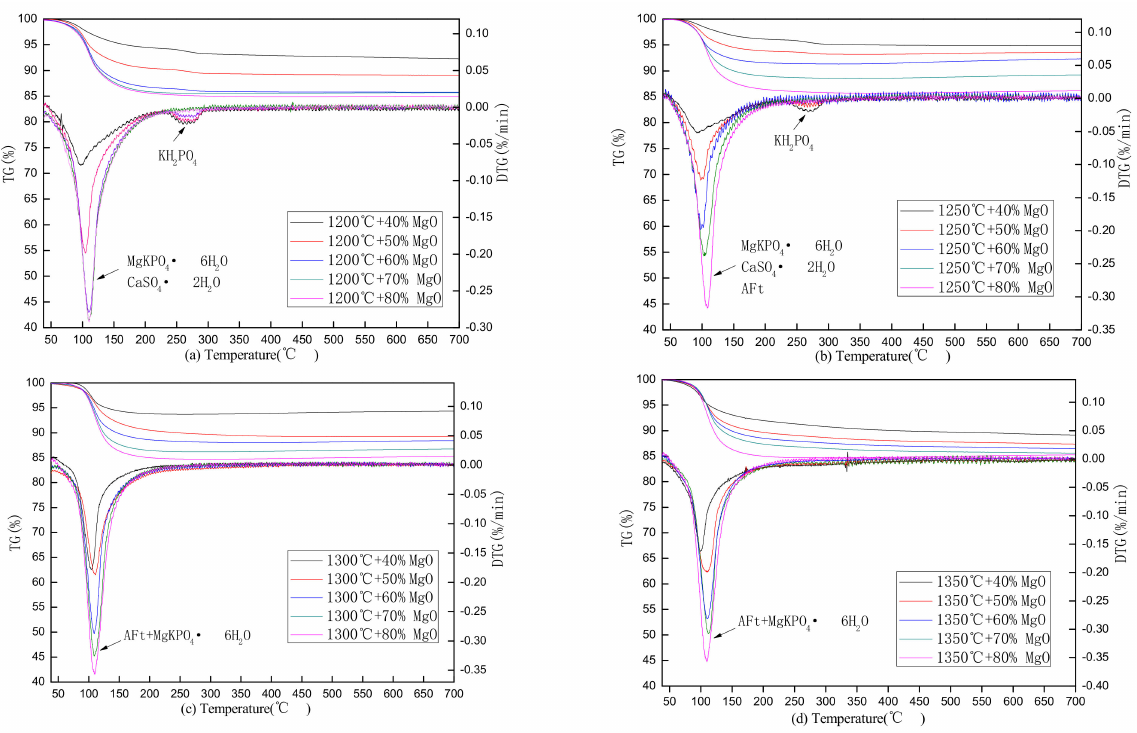
Figure 9. TG-DTG outputs of the SAC-MKPC hydration product at 28 days: ( a ) 1200 ◦ C; ( b ) 1250 ◦ C; ( c ) 1300 ◦ C; ( d ) 1350 ◦